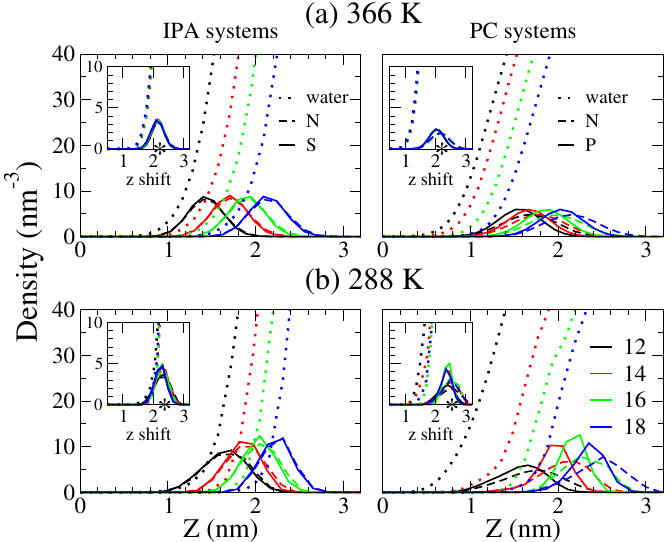
Figure 7. Transverse density profiles for water (dotted line), N atoms for the positively charged trimethylammonium of IPA and choline of PC (dashed line), and the negatively charged groups of S atoms for IPA sulfate and P atoms for PC phosphate (solid line) at ( a ) 366 and ( b ) 288 K, respectively. The color codes for the alkyl chain lengths are black, red, green, and blue for n = 12, 14, 16, and 18, respectively. The insets display the density profiles shifted with respect to the N atom distributions of the systems with the alkyl chain length of n = 18. The most probable positions for N are marked with star symbols (*). The densities for the hydrophilic groups are amplified 5 times for